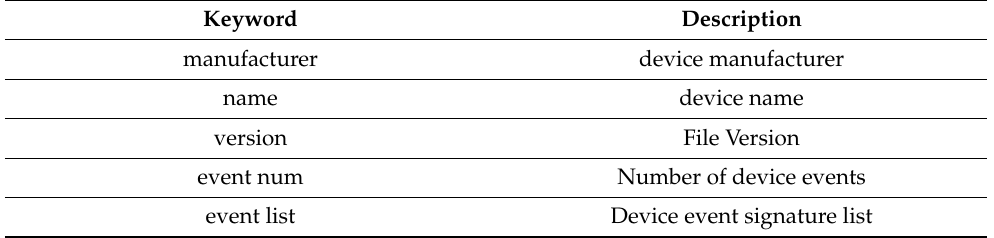
Table 4. Device event signature file.